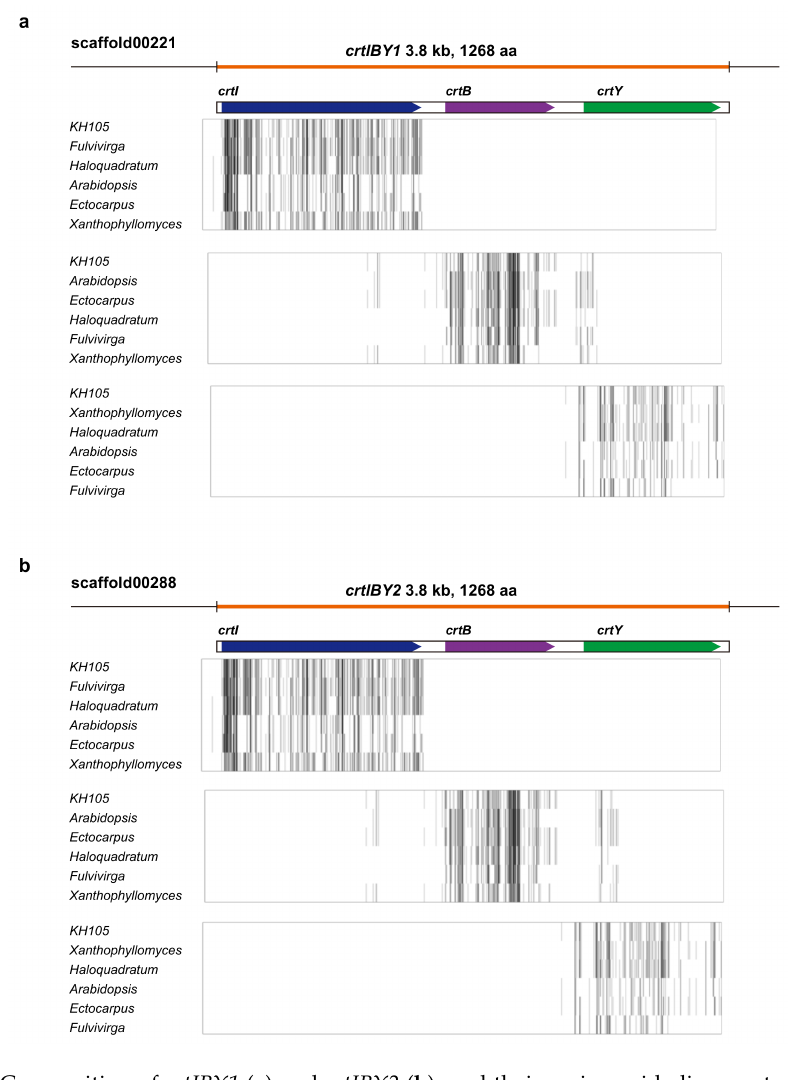
Figure 2. Composition of crtIBY1 ( a ) and crtIBY2 ( b ), and their amino acid alignments with genes of other organisms. Darker lines indicate higher amino acid similarity. GenBank/DDBJ accession numbers are indicated in Supplementary Table